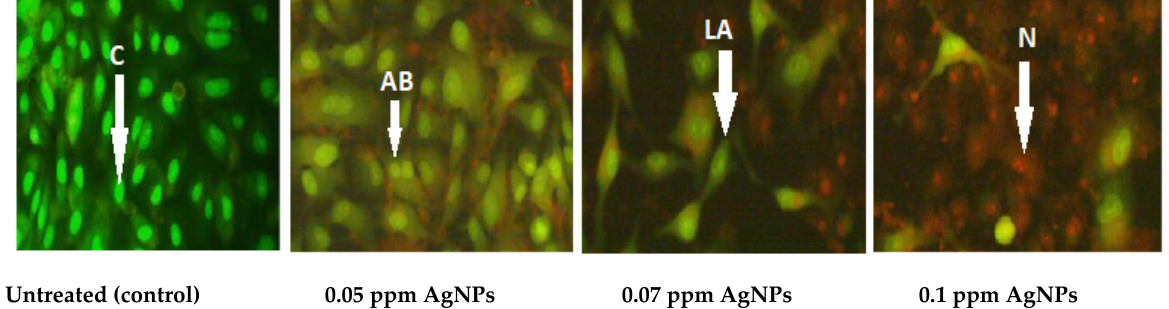
Figure 6. Apoptosis of lung cancer cell line (A549) after treated with AgNPs produced by Streptomyces aizuneusis ATCC 14921. The images were taken using fluorescence microscopy at 20×. C: control cells exhibited green normal nucleus; AB: early apoptosis cells showed bright green nucleus with fragmented chromatin; LA: late apoptosis cells showed condensed red nucleus; AB: an apoptotic body; N: necrosis.